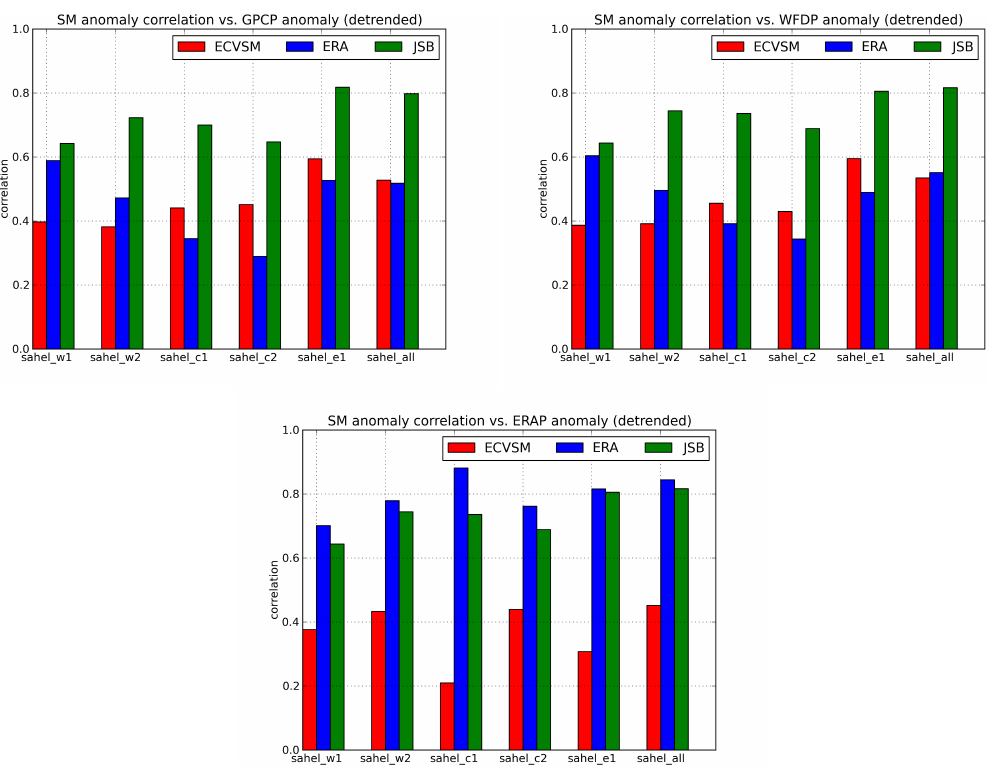
Fig. 11. Correlation coefficient between precipitation and soil moisture anomalies in different regions in the Sahel: GPCP (top left panel), WFD (top right panel) and ERA-interim precipitation (bottom panel). Data was detrended before analysis.